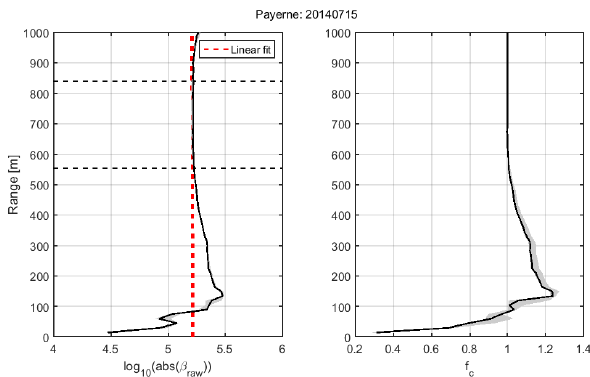
Figure 1. Left panel: logarithm of the absolute value of the range corrected signal measured at Payerne on 15 July 2014 from 00:25 to 01:20. The red line represents the linear fit performed between the two black dashed lines. Right panel: corresponding correction